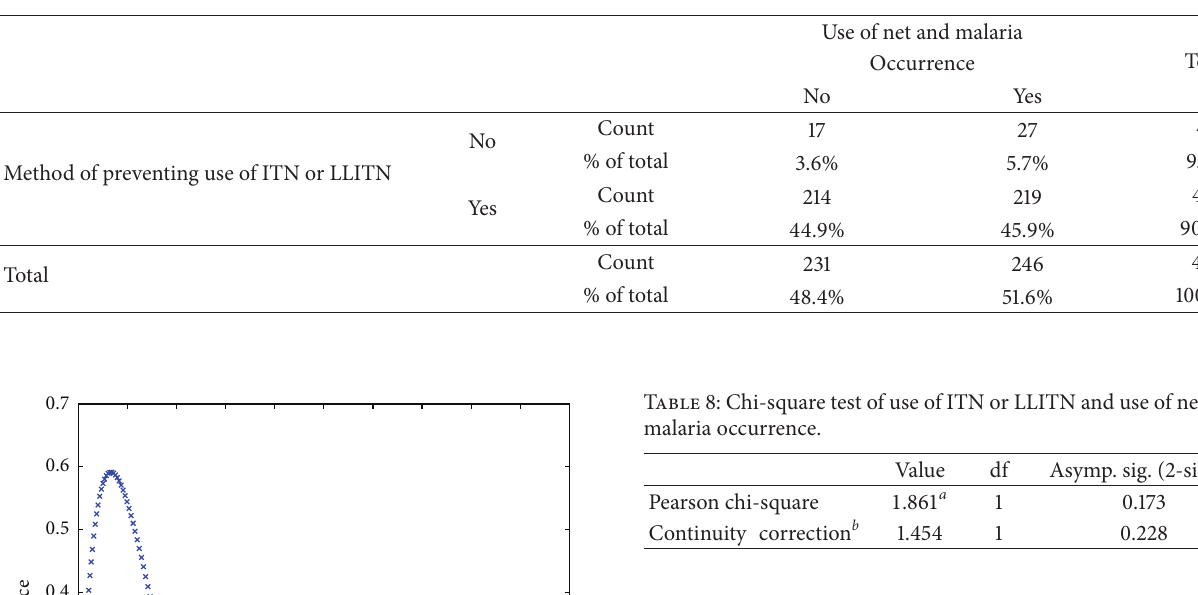
Table 7: Method of preventing malaria use of ITN or LLITN (use of net and malaria occurrence cross tabulation).